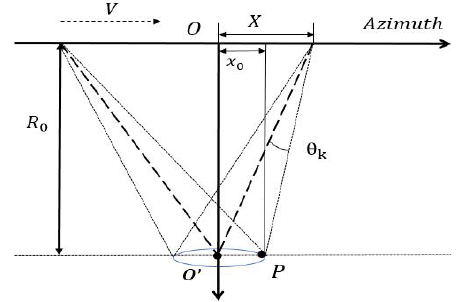
Figure 1. Illuminated geometry of spotlight